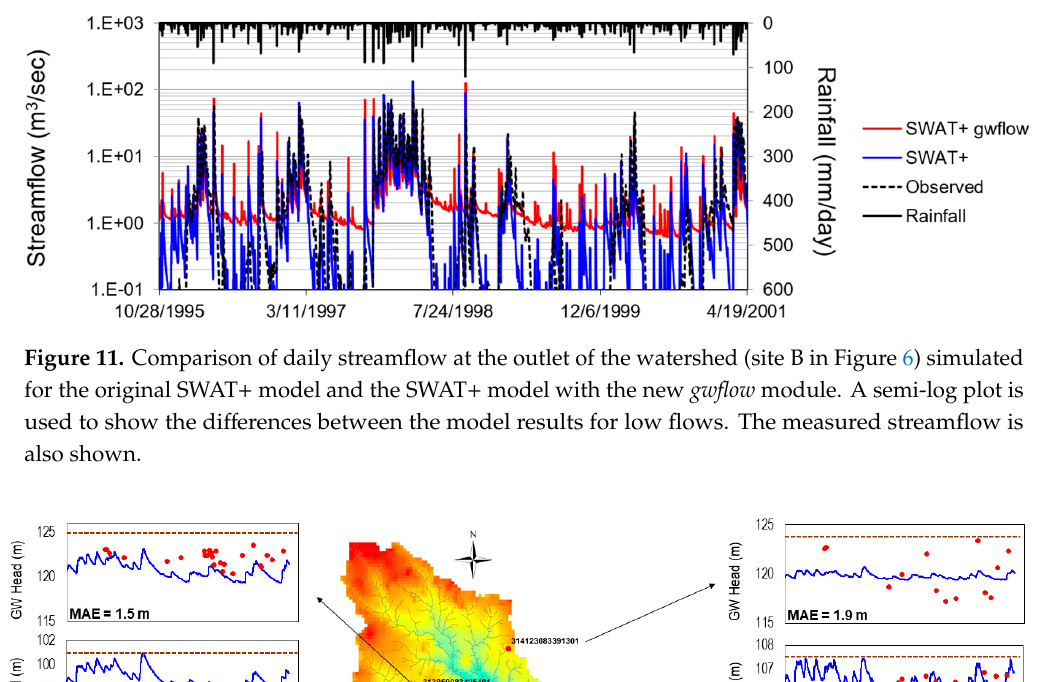
brown line on each time series chart represents the ground surface at that site. Observed rapid